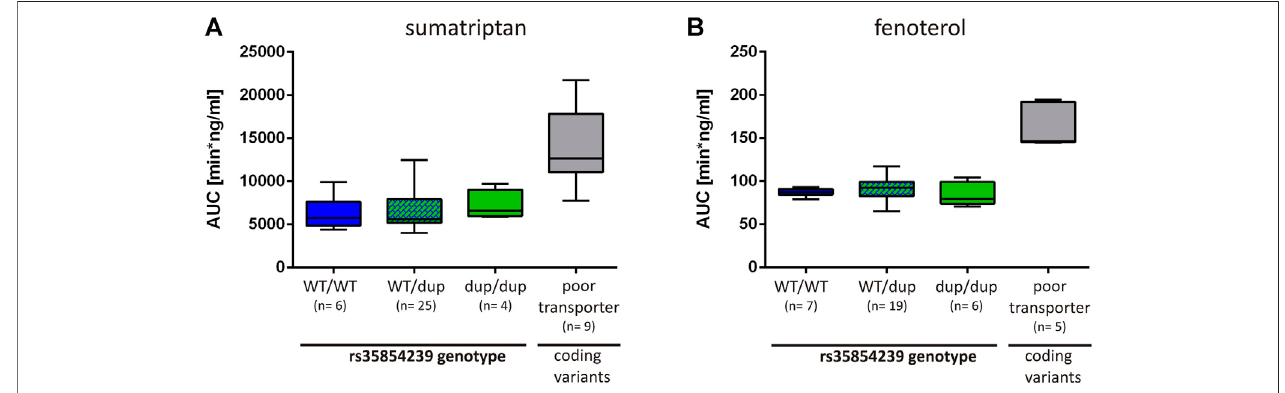
FIGURE 7 | Effects of rs35854239 on the pharmacokinetics of (A) sumatriptan and (B) fenoterol. The AUC of (A) sumatriptan and (B) fenoterol is depicted depending on the rs35854239 genotype and compared to the OCT1 phenotype (poor transporters). Poor transporters comprise homozygous or compound heterozygous carriers of the OCT1 alleles *3, *4, and *5 harboring the coding variants Arg61Cys, Gly401Ser or Gly465Arg, respectively. Dup, rs35854239 duplication allele; WT, wild-type OCT1 allele; AUC, area under the plasma concentration-time curve. Boxplots show median, lower (25%) and upper (75%) quartiles.